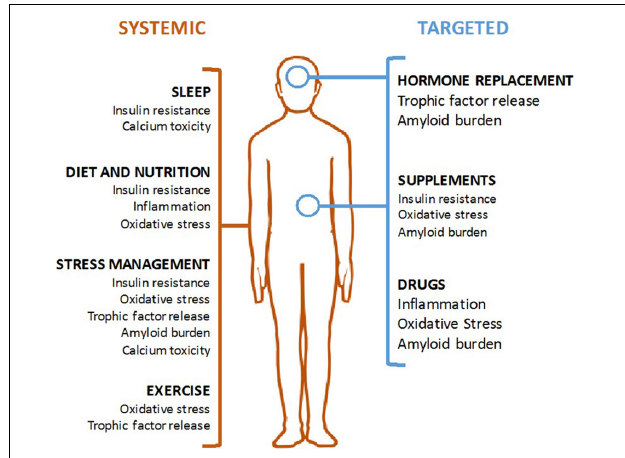
FIGURE 1 | Modalities of Alzheimer’s disease (AD) prevention. Systemic interventions (in orange, on left) should be the foundation of any AD prevention program and are aimed at correcting an unhealthy baseline. Targeted interventions (in blue, on right) can be used for patient with specific indications.